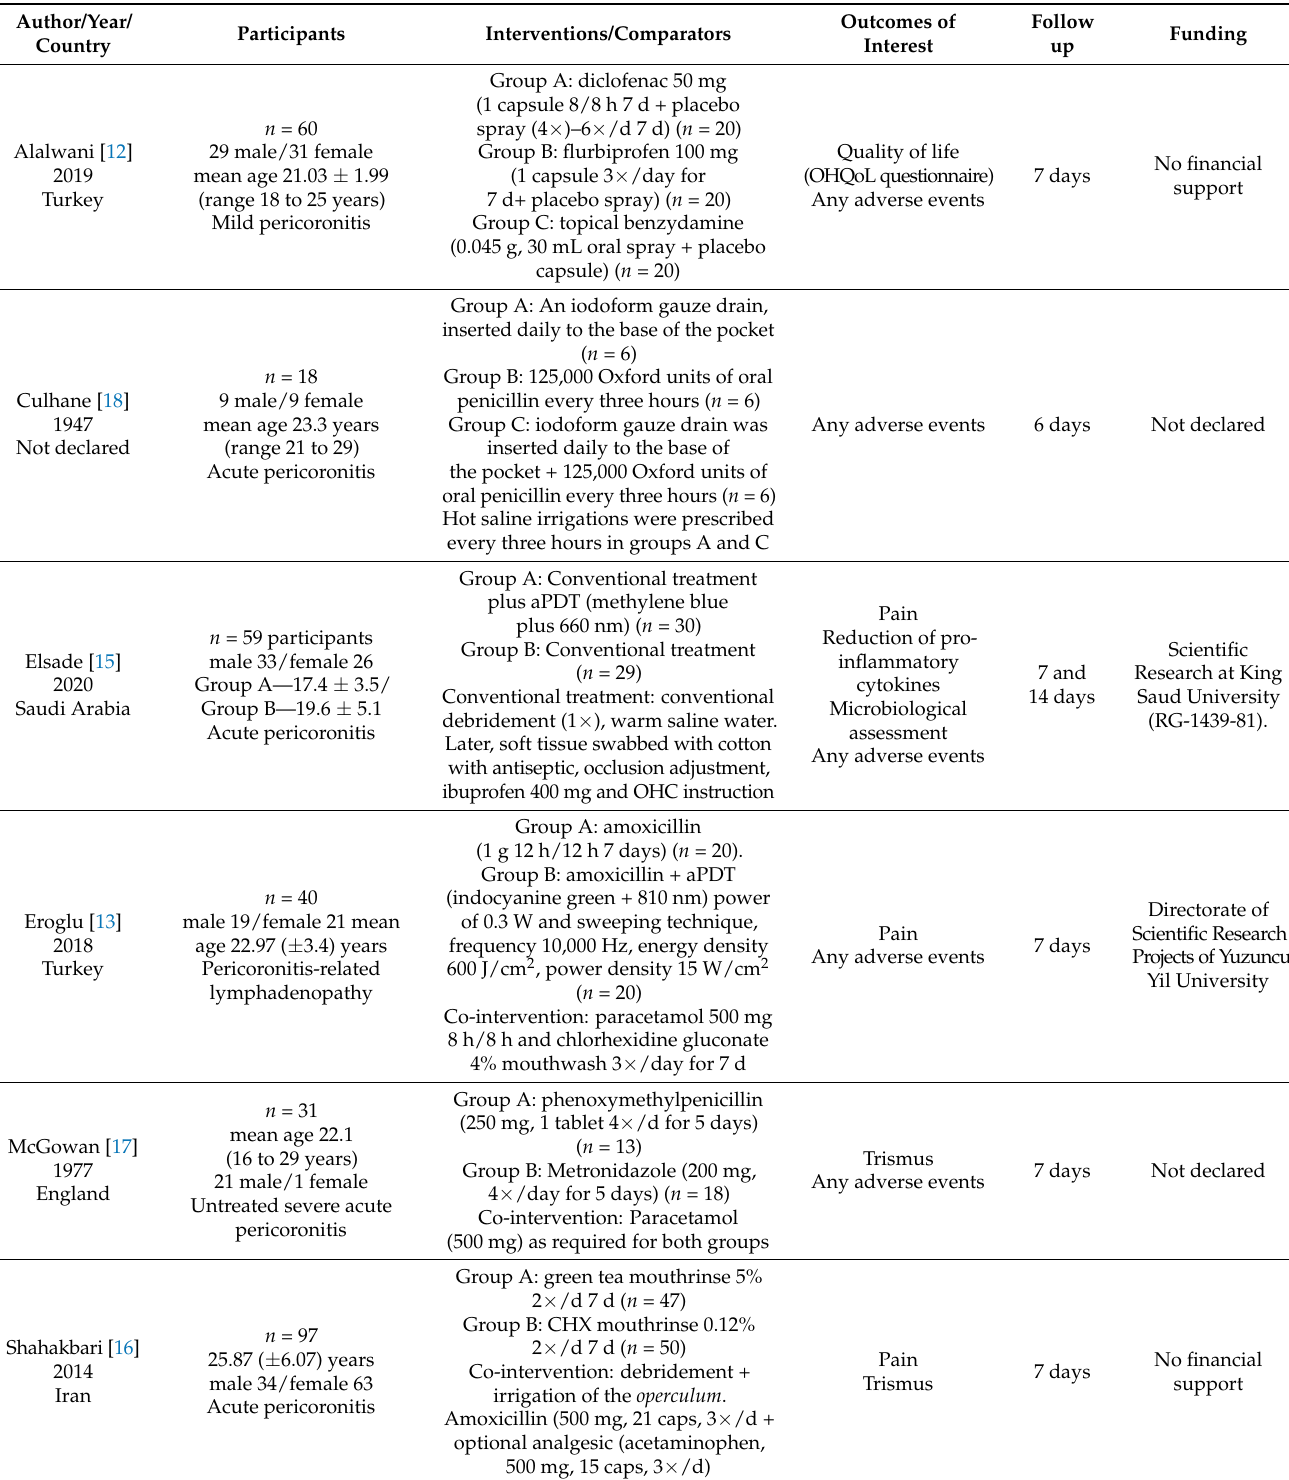
Table 1. Main characteristics of seven full text randomized clinical trials on pericoronitis